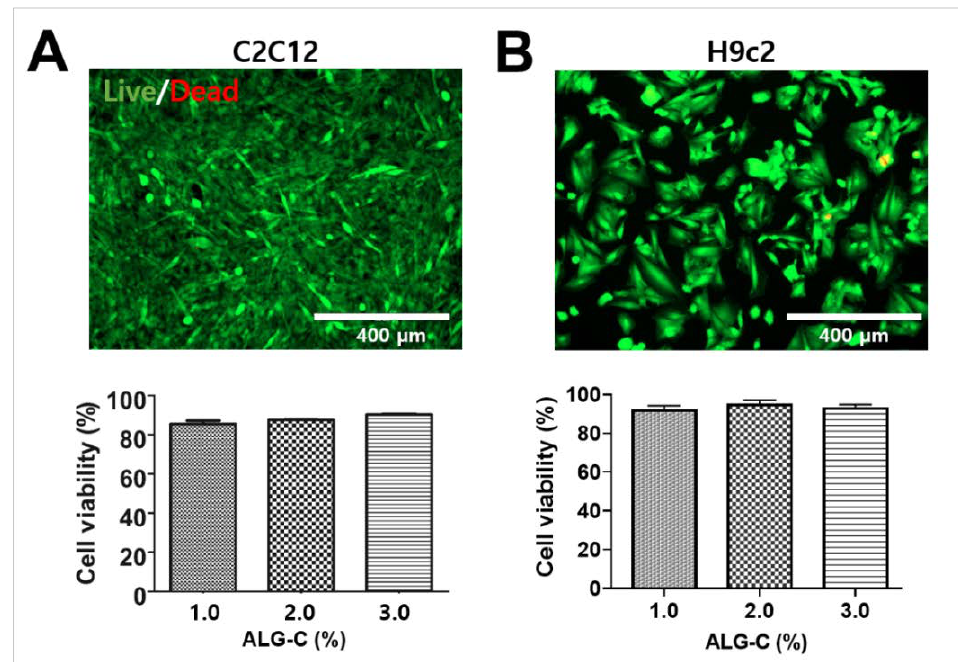
Figure 5. Biocompatibility of ALG-C film hydrogel. Fluorescence image of live (green) and dead (red) cells on the 2% ALG-C film using ( A ) C2C12 cells and ( B ) H9c2 cells. The cell viability was quantified according to ALG-C concentration. All the experiments were conducted in triplicate.